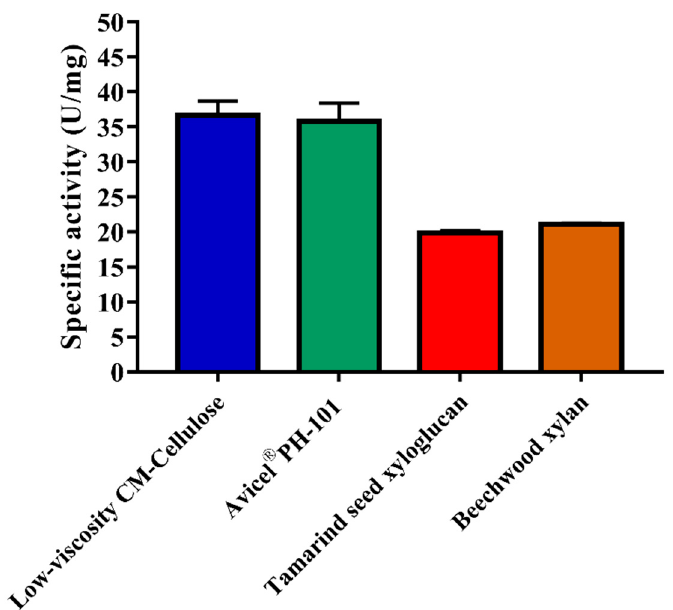
Figure 5. Af Cel6A specific activity (U mg − 1 ) toward CM-Cellulose, Avicel, xyloglucan, and xylan. Each reaction was performed in 50 mM phosphate bufer (pH 6.0) containing 0.5% ( w/v ) of each substrate at 55 ◦ C for 30 min. Values are the mean ± SD of three